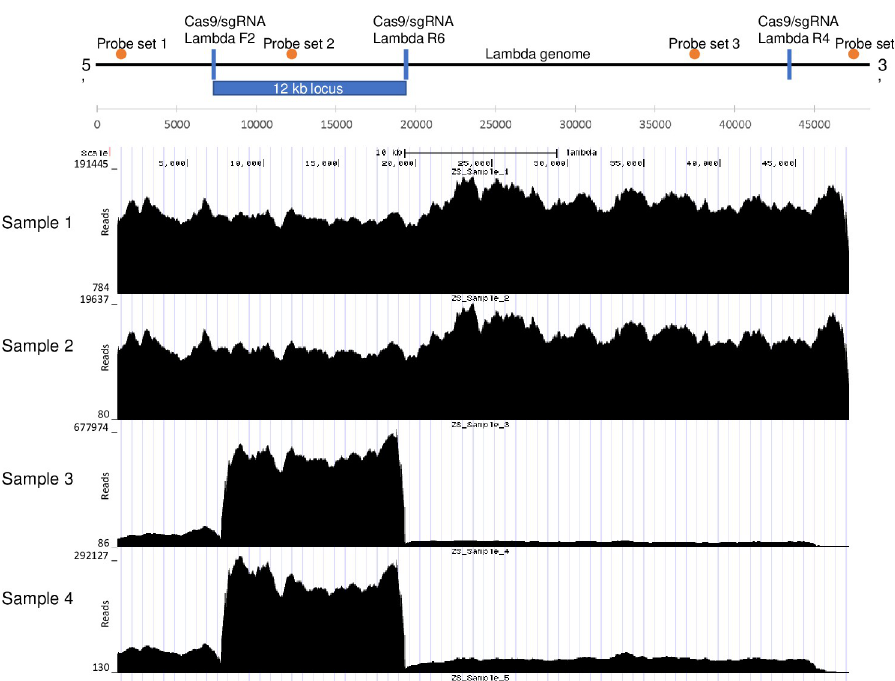
Fig 2. Illumina sequence analyses demonstrate enrichment of the protected 12 kb lambda DNA region. Plots of aligned Illumina reads of the protection experiment mapped to the lambda target genome using BWA 0.7.12-r1039. Sample 1 had no Cas9/sgRNA and no exonuclease treatment with a 120,000:1 copy ratio of lambda to human DNA. Sample 2 had no Cas9/sgRNA and no exonuclease treatment with a 3,000:1 copy ratio of lambda to human DNA. Sample 3 had Cas9/sgRNA Lambda F2 and Lambda R6 treatment with exonucleases III and VII with a 120,000:1 lambda DNA to human genomic DNA copy ratio. Sample 4 had Cas9/sgRNA Lambda F2 and Lambda R6 treatment with exonucleases III and VII with a 3000:1 lambda DNA to human genomic DNA copy ratio.